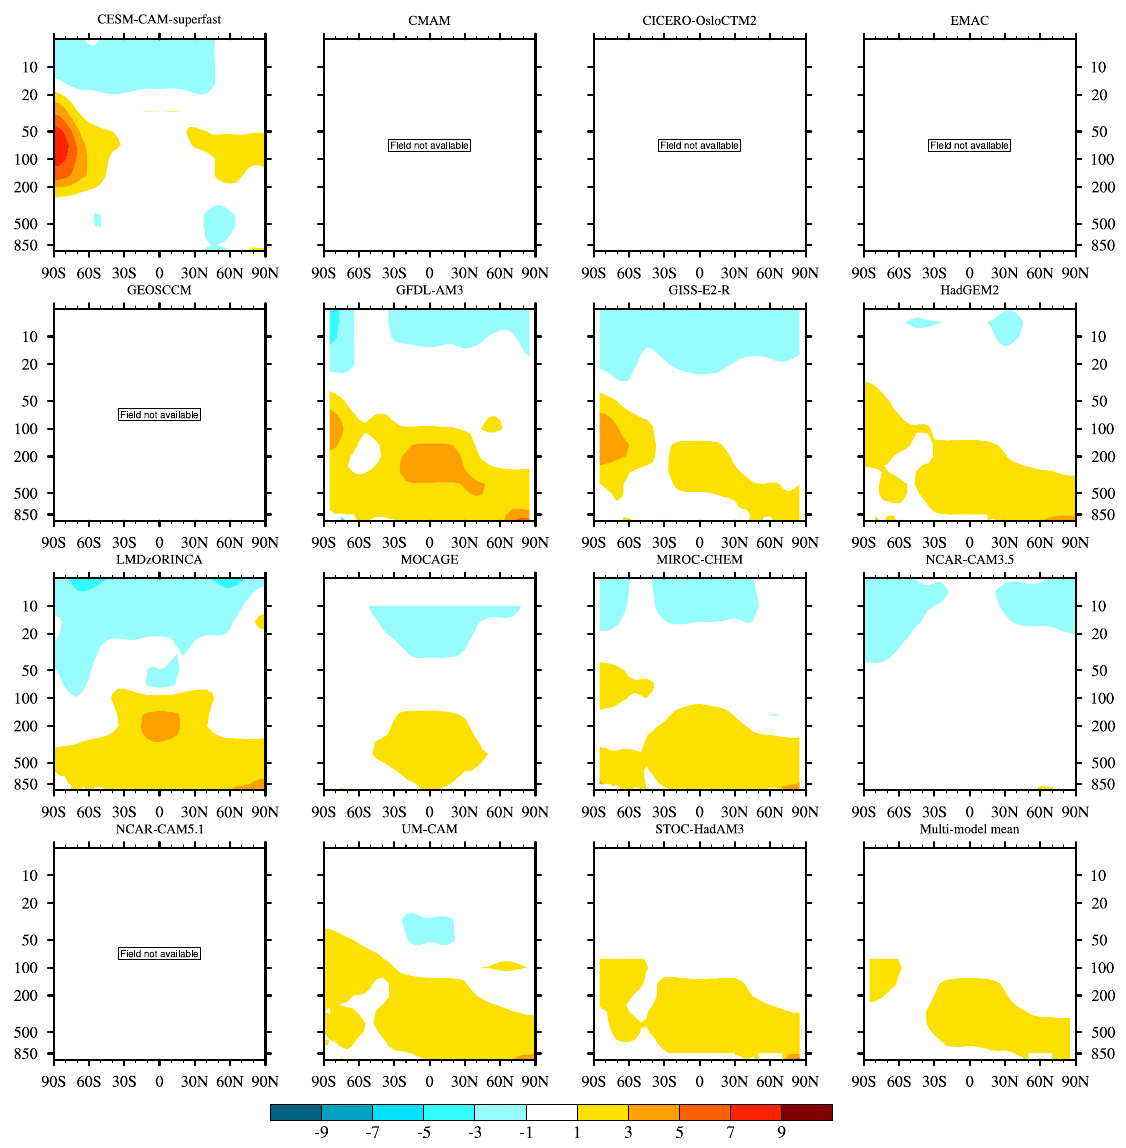
Figure 11b. Difference 2100-­‐2000 in annual and zonal mean temperature (K) for RCP2.6 (note expanded scale from Figure 11a). The CESM-­‐CAM-­‐superfast results are spurious because of a mismatch in the SSTs used (see text for details).